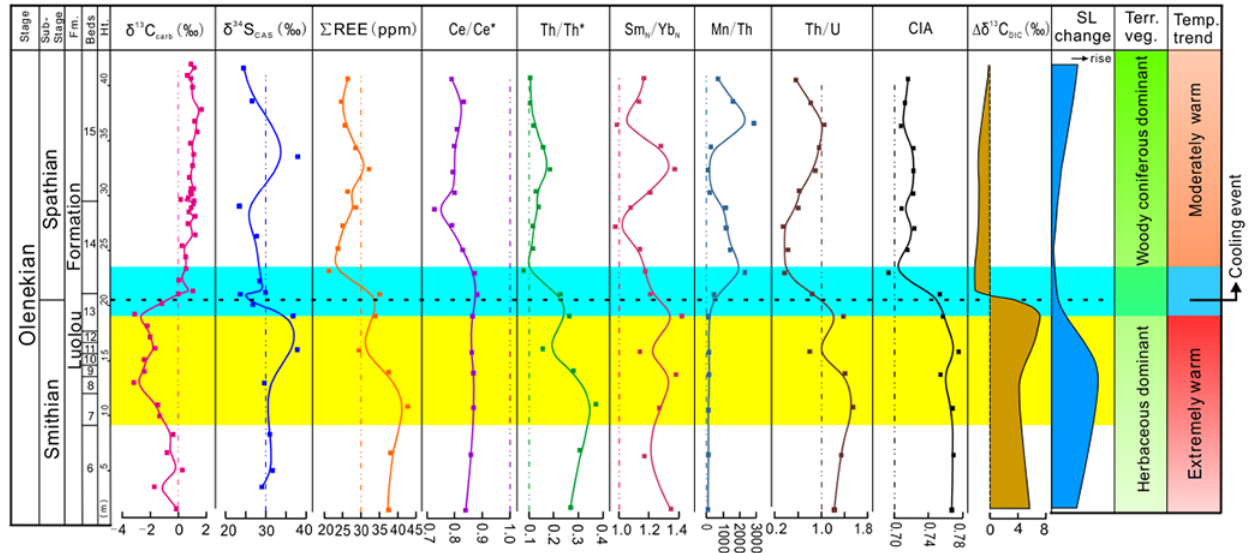
Figure 4. Chemostratigraphic profiles and environmental changes during the Smithian–Spathian transition. The δ 13 C carb and δ 34 S CAS profiles and trace element ratios at Shitouzhai show coupling with vertical gradients in marine carbonate δ 13 C ( (cid:49)δ 13 C DIC ) , global sea-level elevation, and terrestrial vegetation changes during the Olenekian. (cid:49)δ 13 C DIC is from Song et al. (2013), sea-level variation from Yin and Tong (1996), and terrestrial vegetation from Saito et al. (2013). REE, CIA, SL, Terr. veg., and Temp. stand for rare earth elements, chemical index of alteration, sea level, terrestrial vegetation, and temperature,